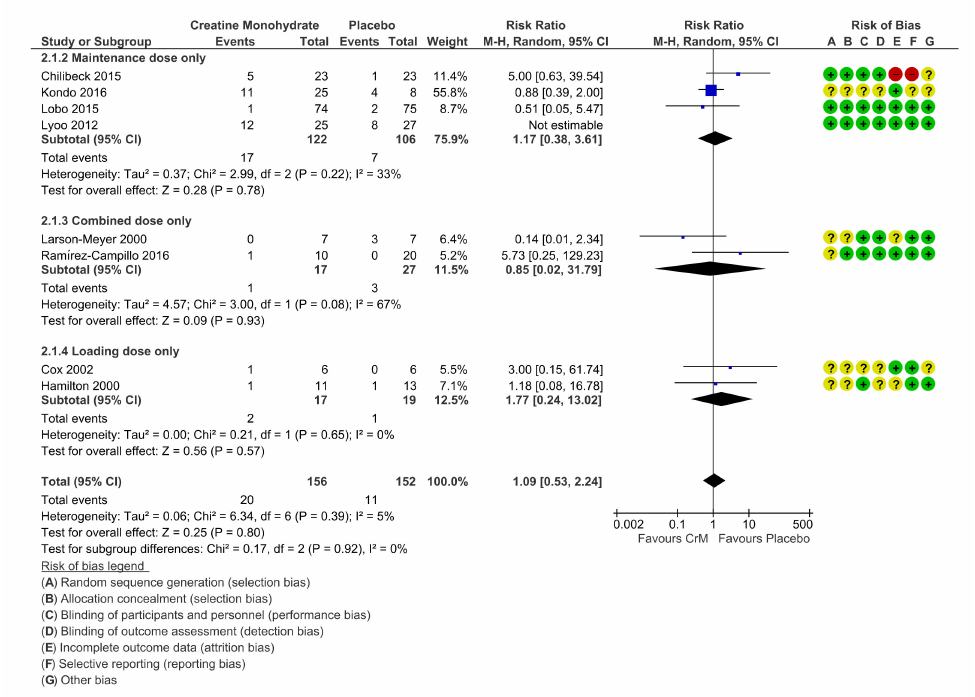
Figure 5. Incidence of gastrointestinal (GIT) events per participant, stratified by dosing regimens. Within Forest Plot, Study or Subgroup = study stratified by dosing regimens; Events = number of adverse events reported; Total = total number of participants in study group; Weight = amount of information contributed by study; M-H = Mantel-Haenszel model; Random = random e ff ects model. Risk of bias; + (green) = low risk of bias, ? (yellow) = unclear risk of bias, - (red) = high risk of